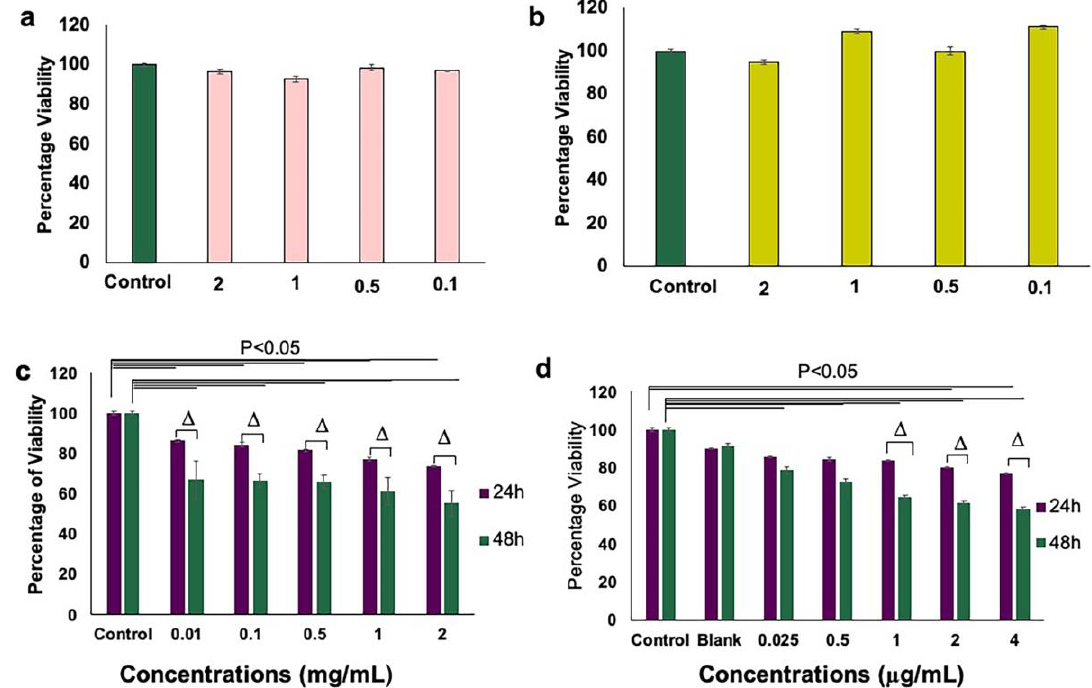
Figure 4. Comparison of HUVEC viability in the presence between aANGP-MCs and free form peptide as assessed by MTT assay. ( a ) Graph showing cell viability after treatment with aANGP without overnight starvation and ( b ) after treatment with aANGP with overnight starvation using 10 ng / mL of VEGF. ( c ) Viability results obtained after treatment with free form aANGP and ( d ) with aANGP-MCs after 24 and 48 h. ∆ -Significance between the samples at 24 and 48 h. Values were expressed as mean ± SD, n = 3. ∆ p < 0.05.